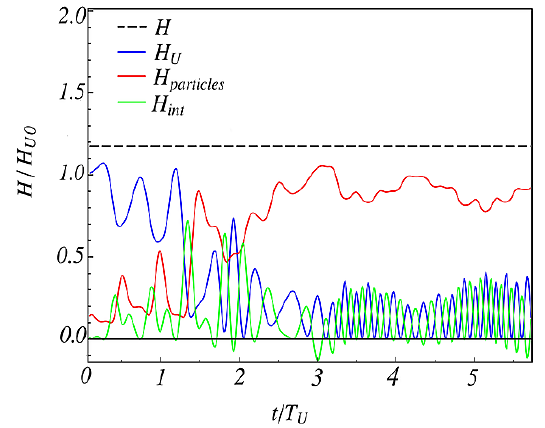
Figure 2. Real-time evolution of the energy density components of the interacting Yang–Mills (YM) system—homogeneous gluon condensate H U and inhomogeneous waves H particles versus the interactions’ contribution H int and the total Hamiltonian H = H U + H particles + H int . Reproduced from Ref.